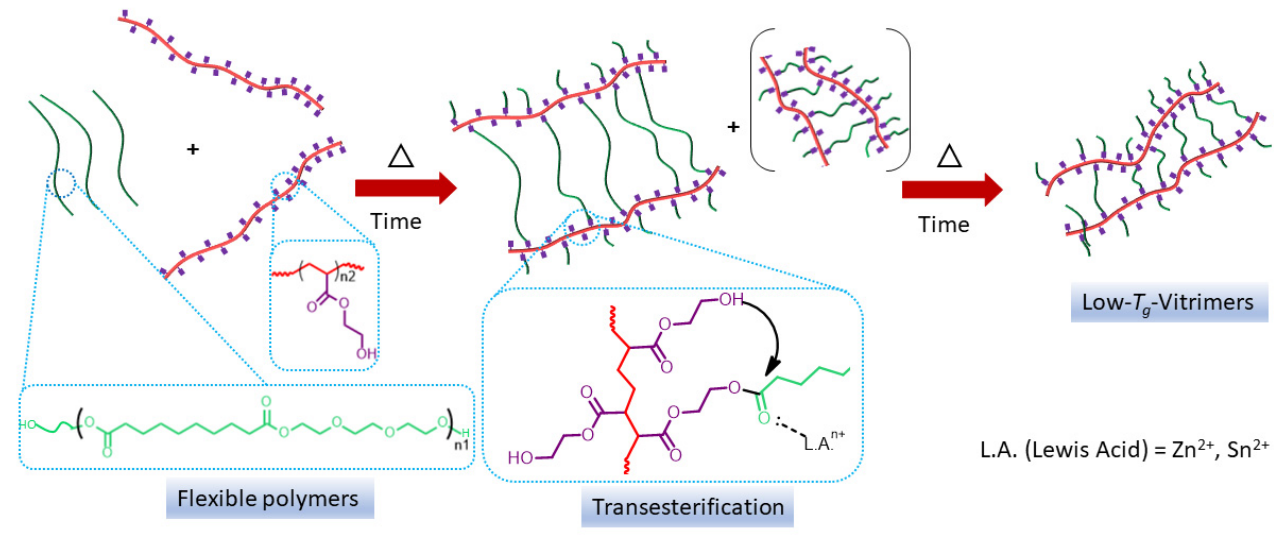
Figure 1. The proposed molecular structure and possible transesterification reactions of the investi- gated vitrimers. The triangle symbol ( Δ ) represents heating.